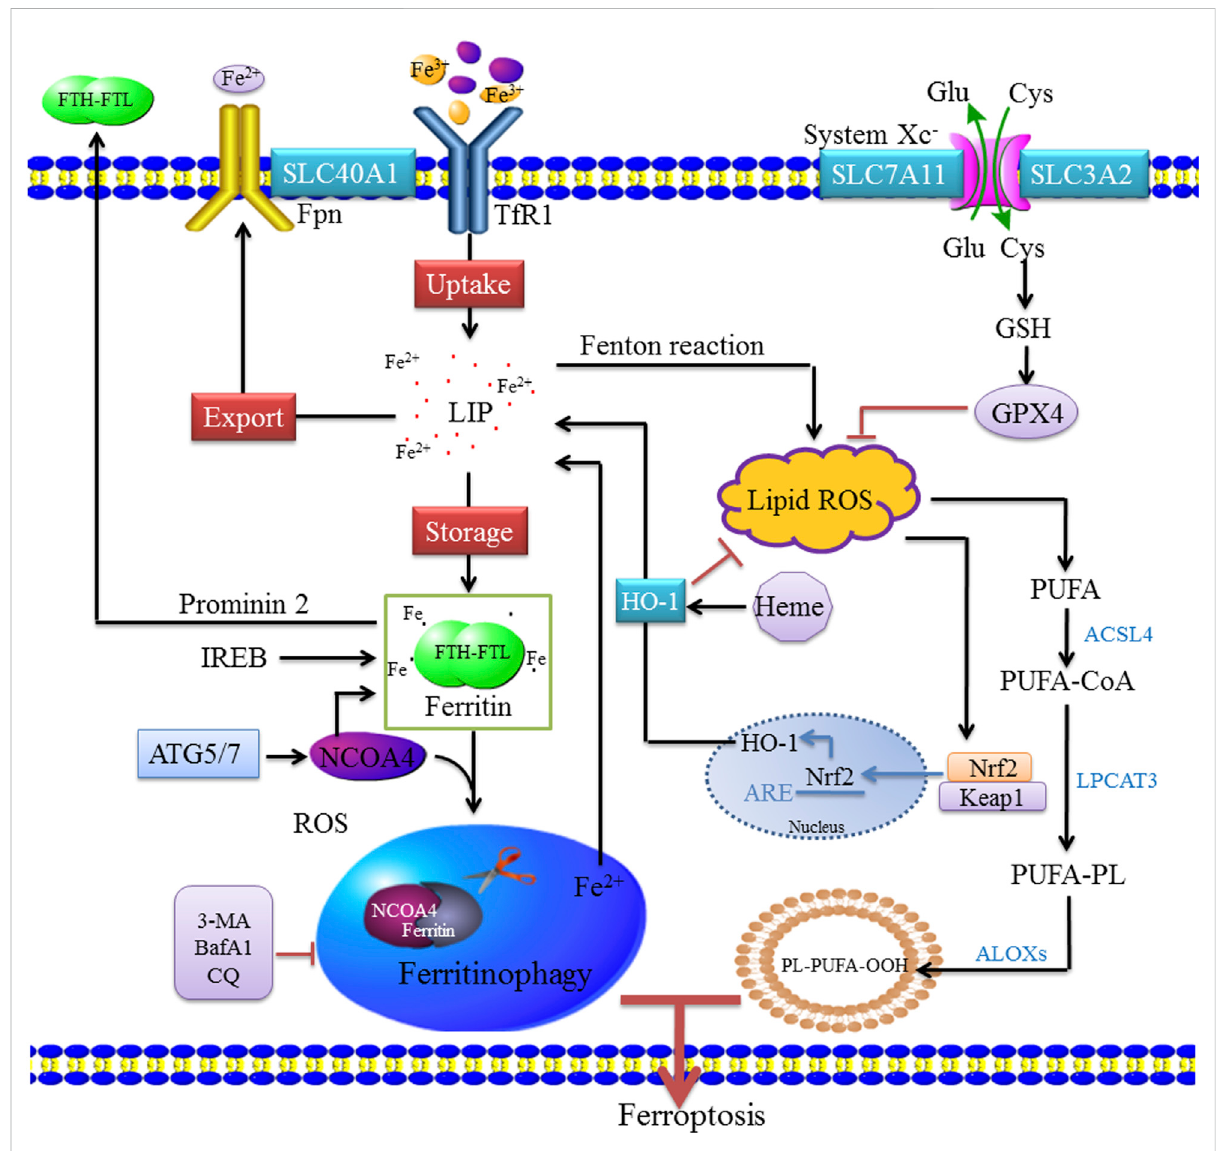
FIGURE 1 Molecular mechanisms of ferritinophagy. Extracellular Fe 3+ relies on Tfr1 for transferring into the cell to form Fe 2+ , where it binds to form a ferritin storage cage, which is composed of FTL and FTH. Fe 3+ is reduced to Fe 2+ in the endosome by STEAP3 (iron reductase), which then mediates the release of Fe 2+ from the endosome into the cytoplasm via DMT1/SLC11A2 to form LIP. Cytoplasmic Fe 2+ can be reduced by ferritin and stored as Fe 3+ , and Fe 2+ can be transported out of the cell by ferroportin (FPN1/SLC40A1). These mechanisms of controlling iron intake, storage, and export maintain the amount of iron in the redox-active LIP. When bioavailable iron levels are low, the body regulates the release of iron and replenishes ferritinthrough selectiveautophagy degradation. When autophagy is activated, NCOA4 mediates the binding of ferritin to the lysosome, causing it to degrade and release free iron. NCOA4 promotes its autophagic degradation by binding ferritin, leading to the formation of ferritinophagy, whereas the inhibition of autophagy leads to the accumulation of NCOA4. Ferritinophagy leads to increased intracellular iron levels andROSaccumulationthroughtheFentonreaction,leadingtoferroptosis.ACSL4isinvolvedinthebiosynthesisofPUFAsandhelpsfreePUFAstobe esteri fi ed and incorporated into membrane phospholipids. Nrf2 activates HO-1, which leads to an increase in heme degradation. An imbalance among these homeostatic factors could lead to an accumulation of excess intracellular iron, increased ROS production, and induction of cell